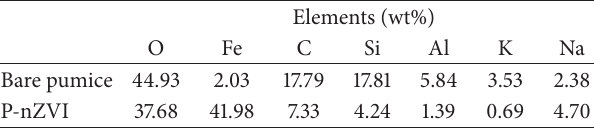
Table 1: Chemical composition of bare pumice and P-nZVI obtained by EDS